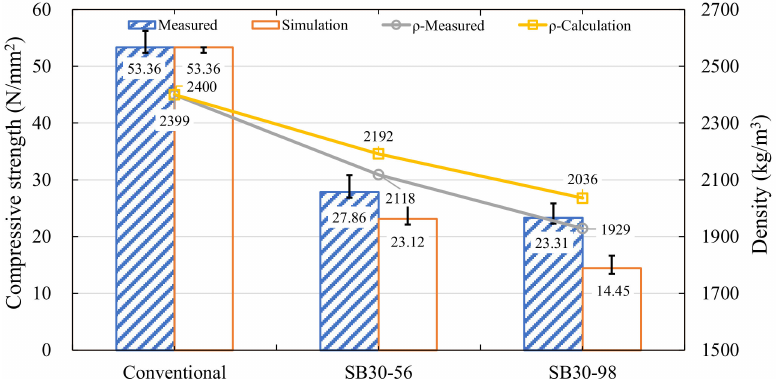
Figure 8. The density and compressive strength of SB concrete.